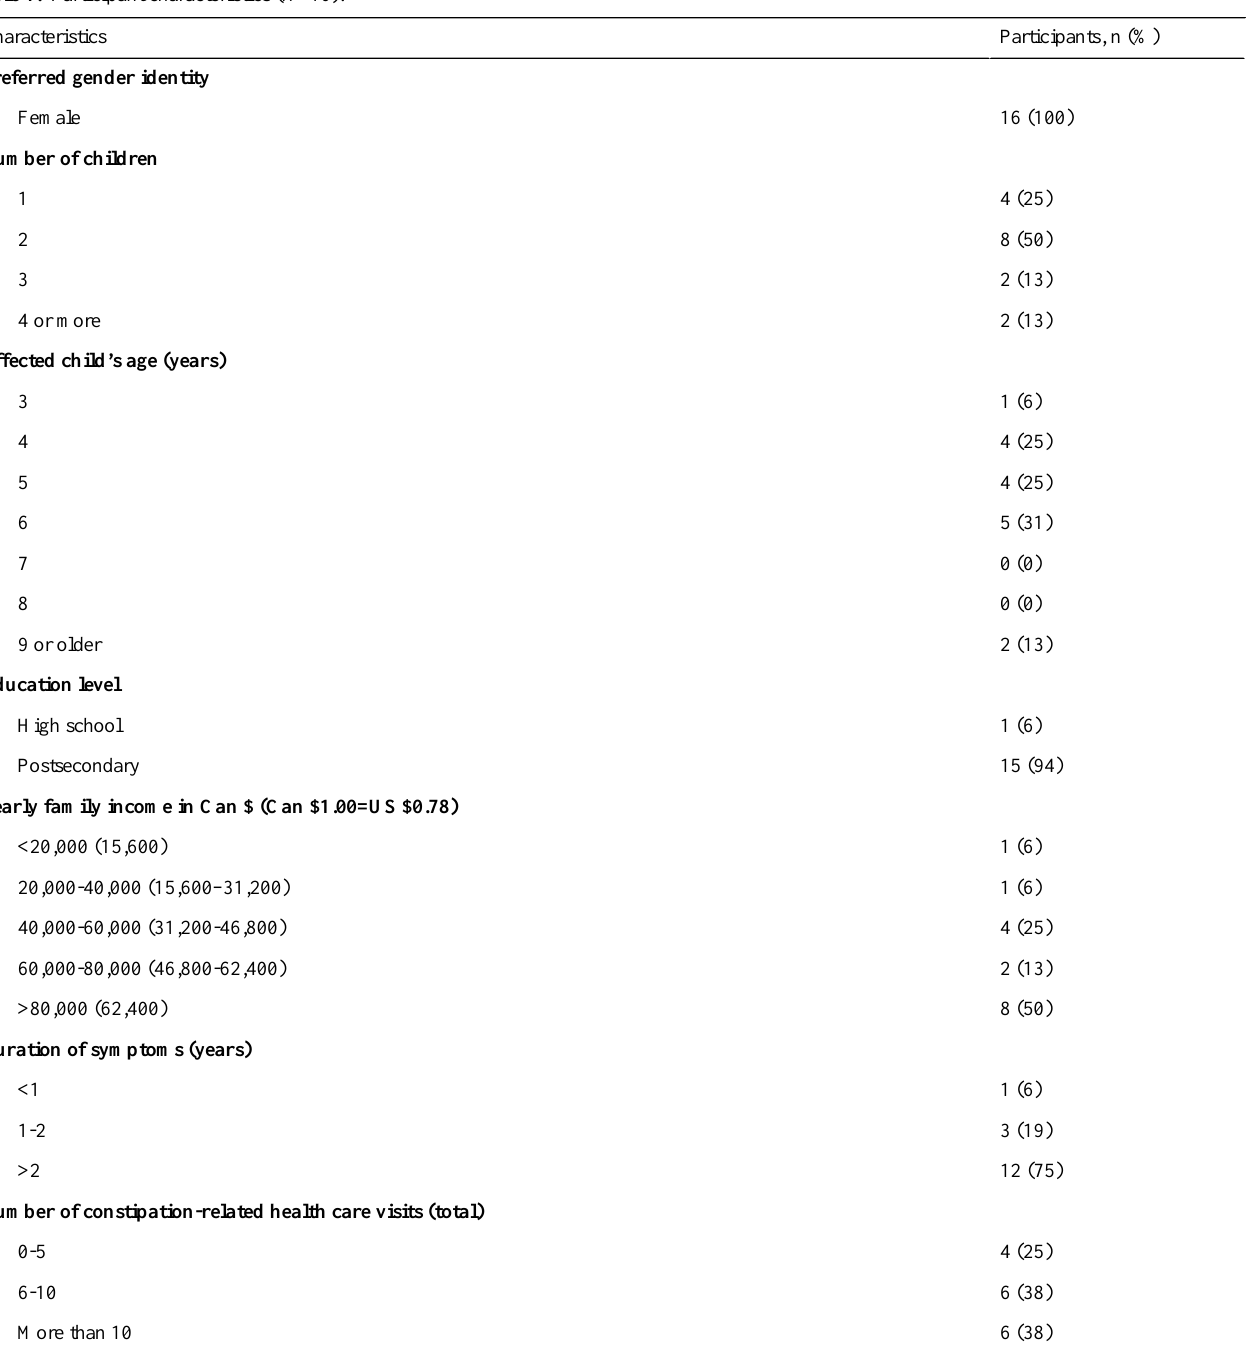
Table 1. Participant characteristics